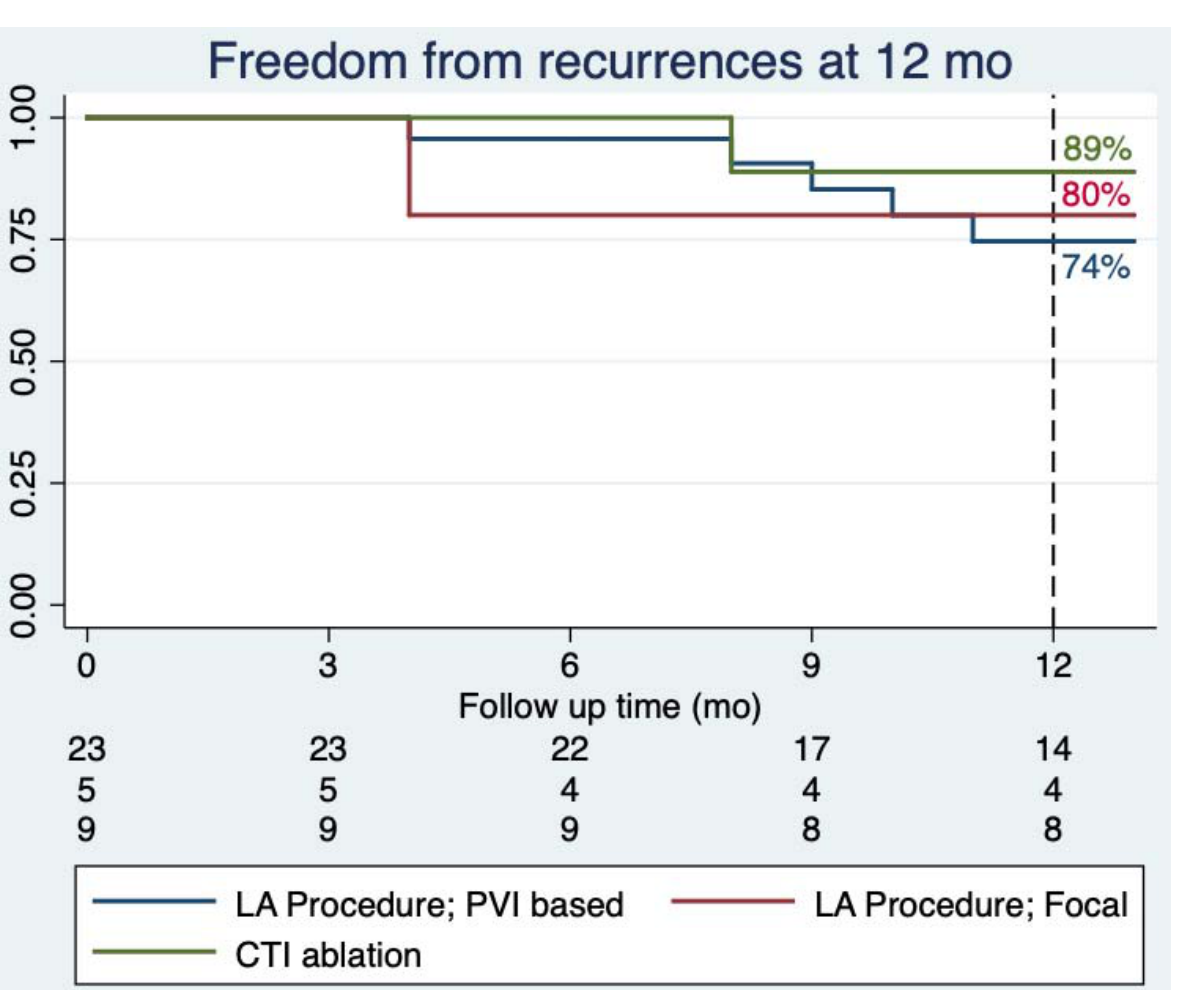
Figure 1. Single-procedural freedom from atrial arrhythmia recurrences stratified by ablation procedure performed at 12 months. CTI: cavotricuspid isthmus; LA: left atrial; PVI: pulmonary vein isolation. Table 4. Cohort outcomes at follow up.